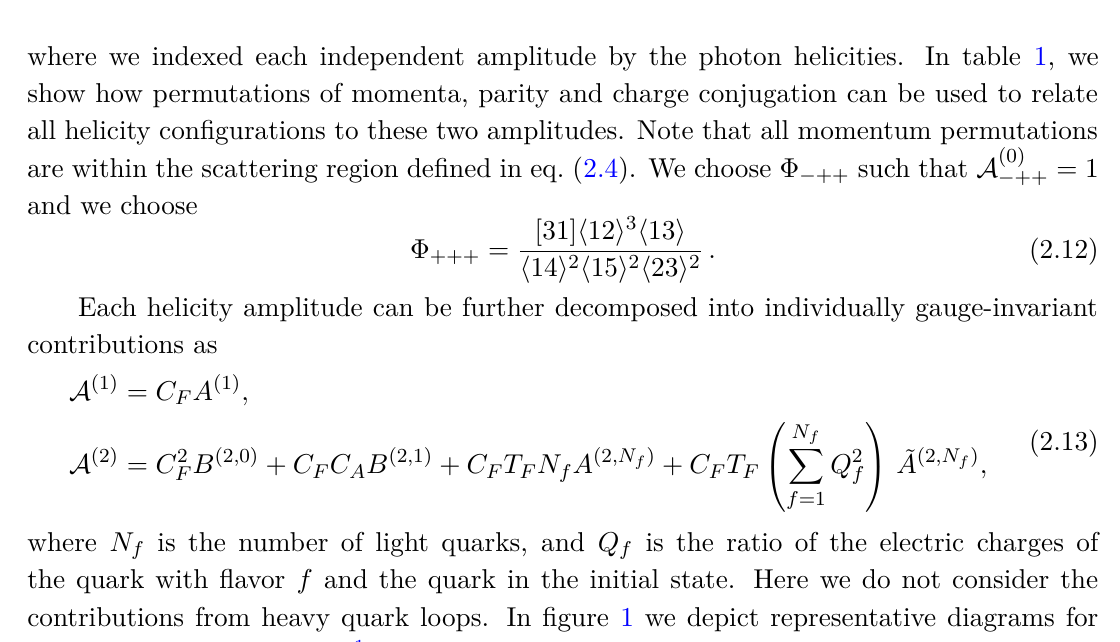
Table 1. Relation between all helicity configurations and the two independent basis elements in eq. (2.11). P denotes a parity